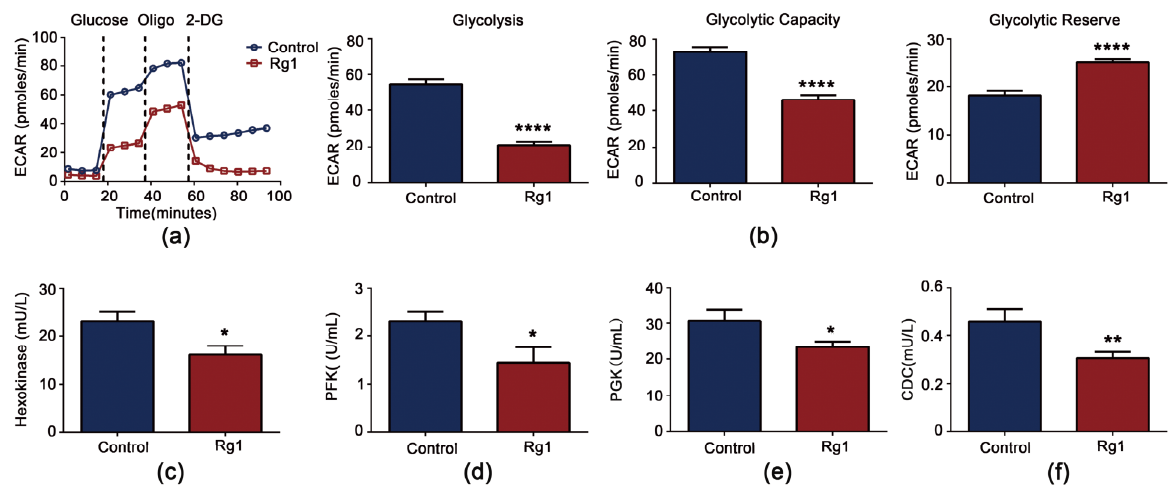
Figure 7. Effects of Rg1 treatment on glycolysis in S. cerevisiae . ( a ) Graphical representation of extracellular acidification rate (ECAR) measurements over time. ( b ) Calculation of representative functional parameters of glycolysis from ECAR curves. “Glycolysis” indicates the ECAR when glucose was injected; “Glycolytic Capacity” indicates the ECAR when oligomycin was injected; “Glycolytic Reserve” indicates the difference between Glycolysis and Glycolytic Capacity. Activities of the enzymes hexokinase ( c ), phosphofructokinase (PFK) ( d ), phosphoglycerate kinase (PGK) ( e ), and CDC19 ( f ) detected by using enzyme-linked immunosorbent assay kits. Data are expressed as the mean ± SD; n = 3. Compared with untreated controls, * p < 0.05, ** p < 0.01, **** p < 0.0001.